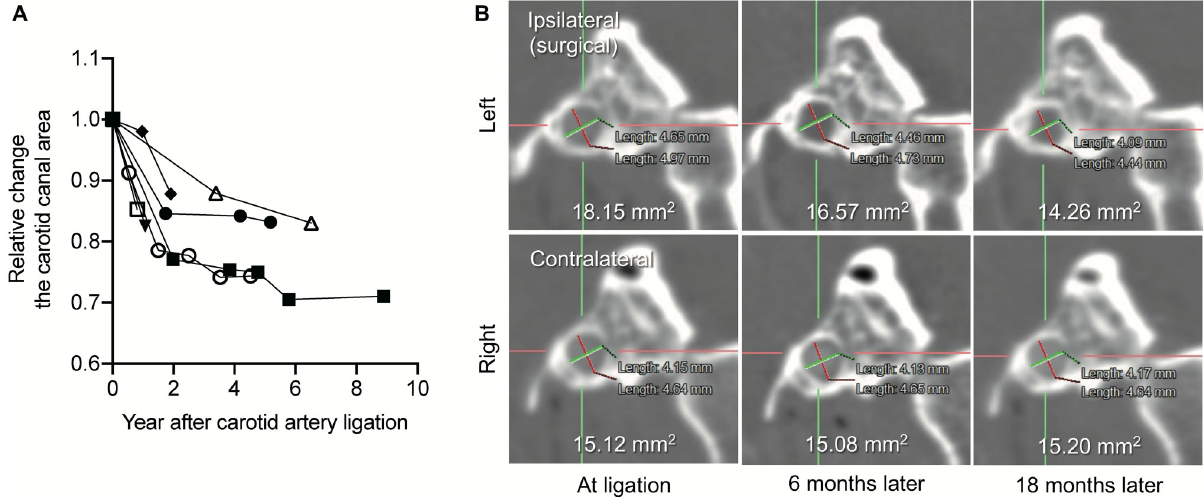
Fig 1. The bony carotid canal narrows after carotid artery ligation. (A) shows the carotid canal area measured in seven patients who underwent carotid artery ligation. The area decreases continuously over years in all cases, with relative changes of 12.2%–28.9%, demonstrating carotid canal plasticity. (B) shows a representative case who underwent carotid artery ligation. Six months after surgery, the carotid canal area on the surgical side had narrowed from 18.15 mm 2 to 16.57 mm 2 ; 18 months after surgery, it had narrowed to 14.26 mm 2 . In contrast, the carotid canal area of the contralateral side did not